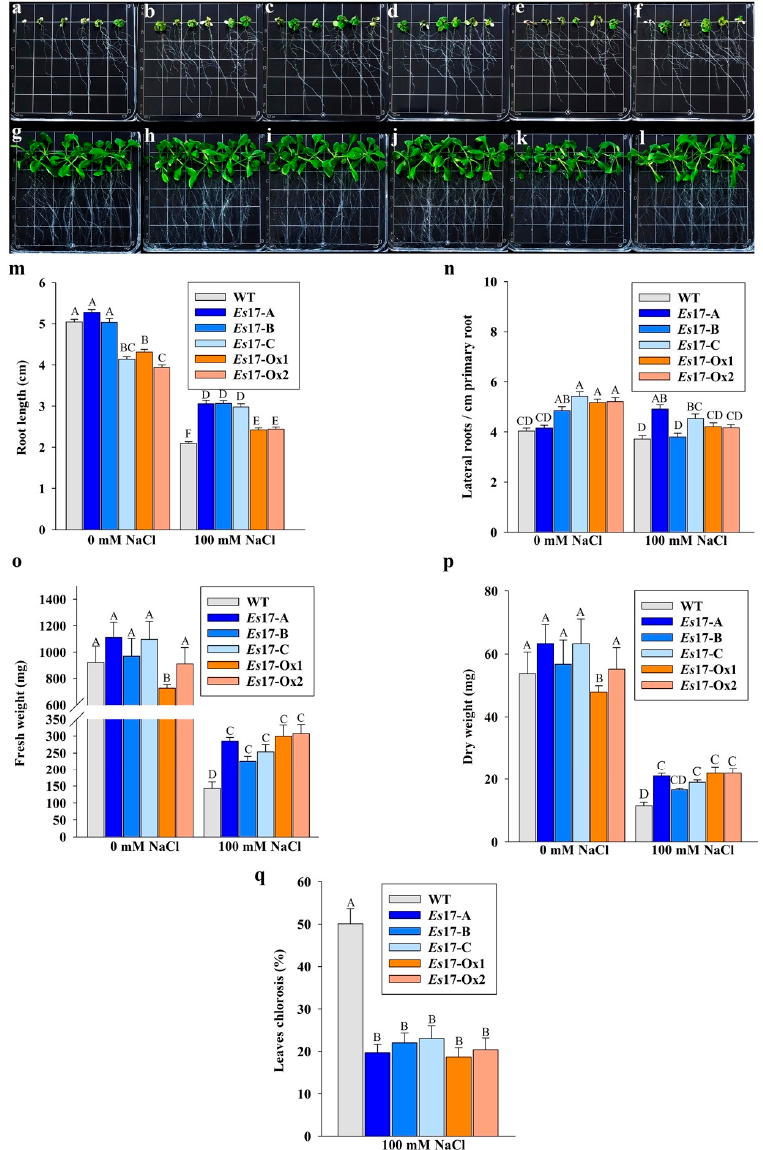
Figure 3. Growth of wild type and 2 independent 35S promoter ( Es 17Ox-1-2,) and of 3 independent stress inducible promoter ( Es 17A-C) transgenic A. thaliana seedlings, expressing Esi0017_0056 in presence and absence of 100 mM NaCl. In plates ( a – f ), seedlings were grown under salt stress conditions while in plates ( g – l ), seedlings were grown in standard conditions. ( a , g ) WT, ( b , h ) Es 17-A, per cm of primary root, ( o ) fresh weight, ( p ) dry weight and ( q ) leaf chlorosis. Values represents mean and standard error ( n = 90) for root length, lateral roots, leaf chlorosis and n = 9 for fresh and dry weight. Means and SE followed by the same letter are not significantly different. The plants were photographed at 9 days after transfer in standard and under salinity stress